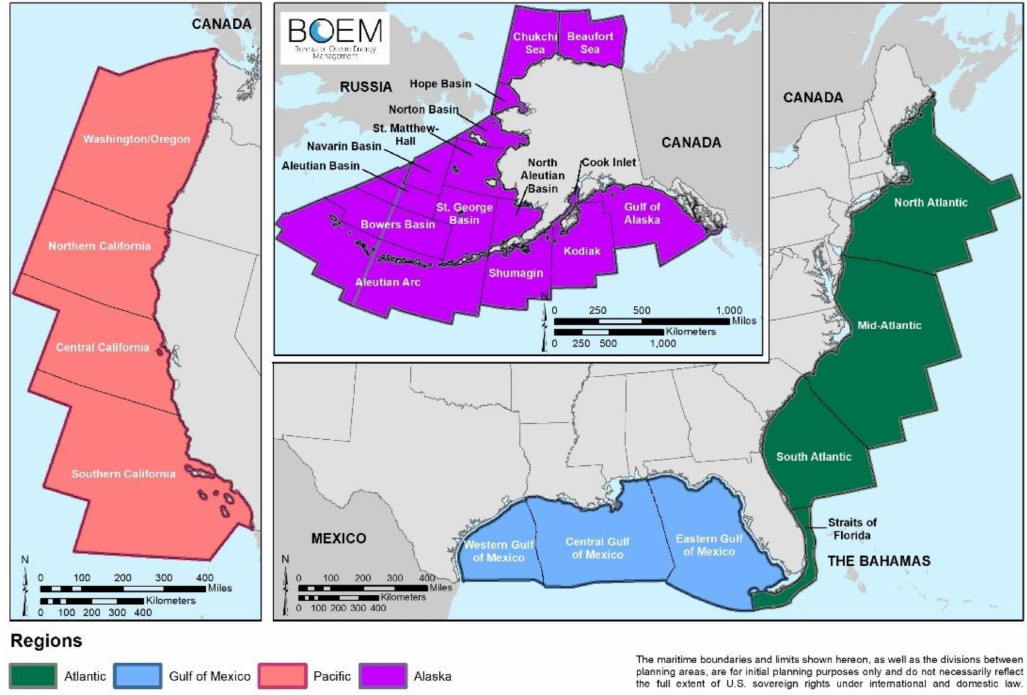
Figure 2. The U. S. OCS is divided into the Alaska, Pacific, GOM, and Atlantic